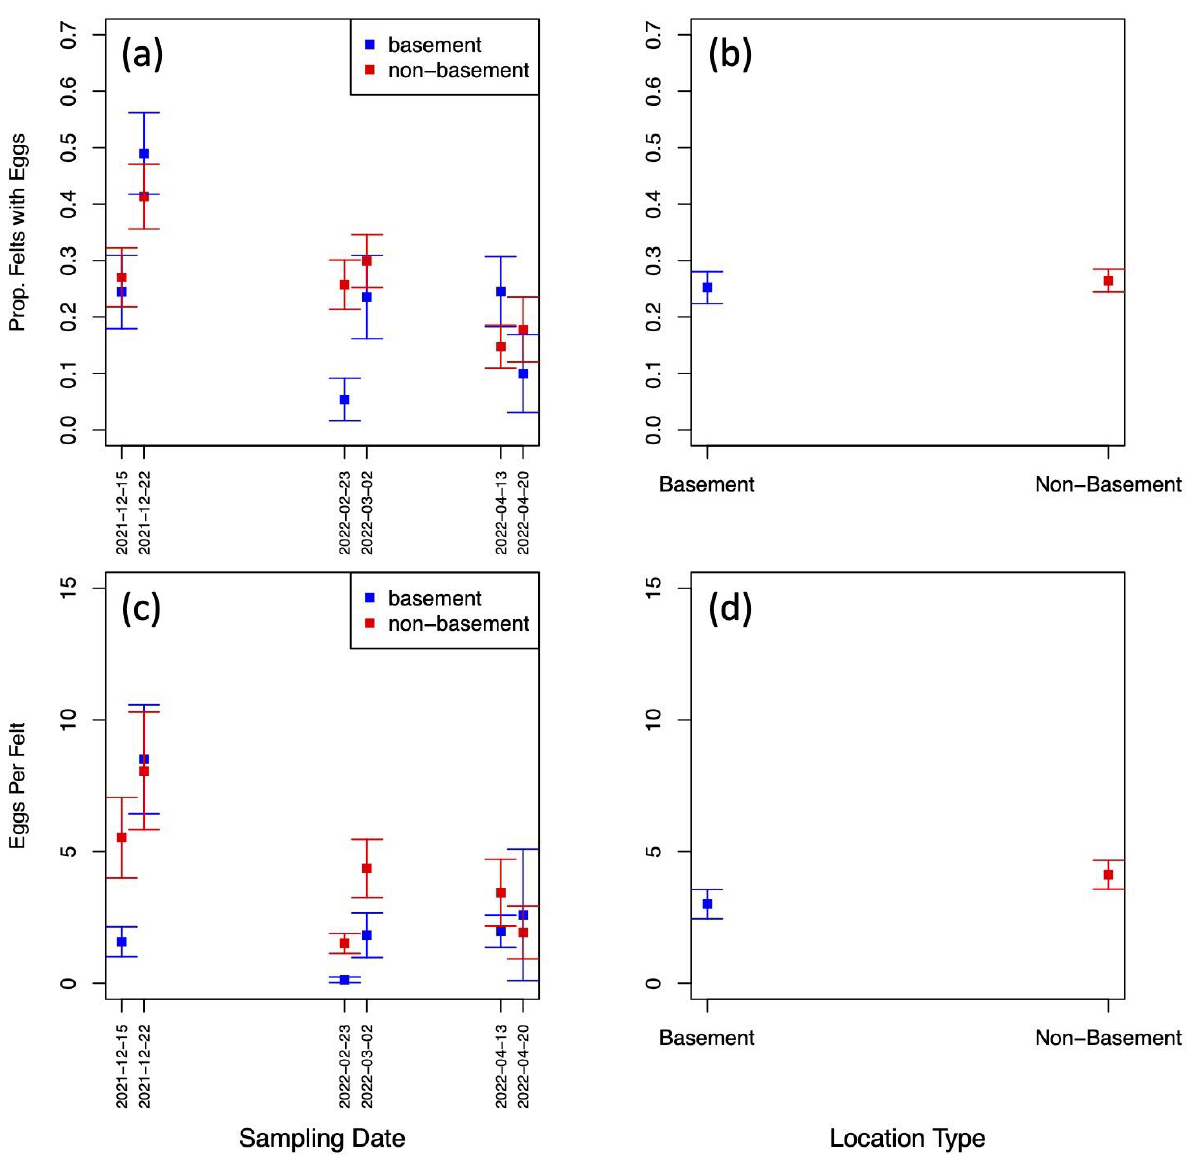
Figure A1. ( a ) Proportion of egg-positive felts collected from basement and non-basement locations in As-Salamah plotted by collection date; ( b ) Proportion of egg-positive felts collected from basement and non-basement locations in As-Salamah, aggregated over all collection dates; ( c ) mean numbers of eggs on felts collected from basement and non-basement locations in As-Salamah plotted by collection date; ( d ) mean numbers of eggs on felts collected from basement and non-basement locations in As-Salamah, aggregated over all collection dates; Bars extending from plotted squares show the standard errors of the estimates.